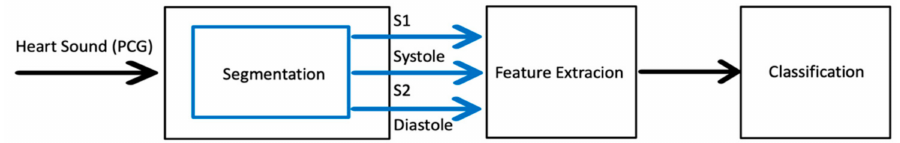
Figure 1. General steps for the automated heart sound classification